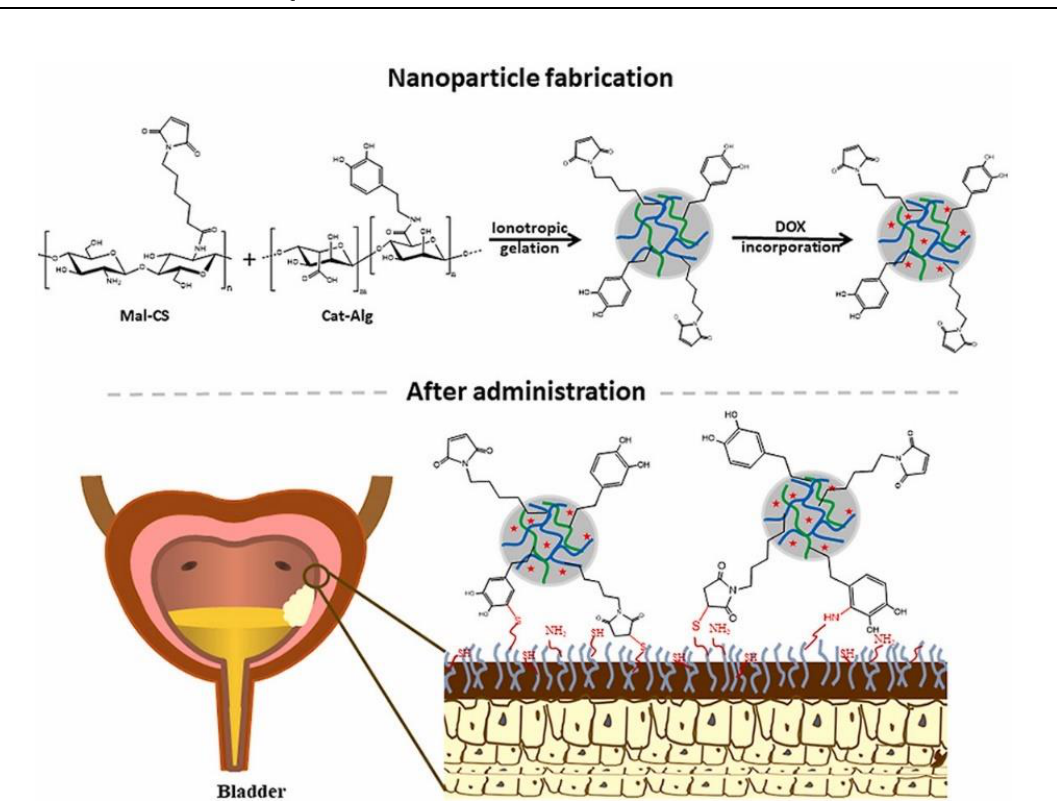
Figure 5. Schematic representation of the synthesis mechanism and final structure of the delivery system developed by Sahatsapan et al. [106]. Reprinted with permission from [106], © 2021, Elsevier B.V.